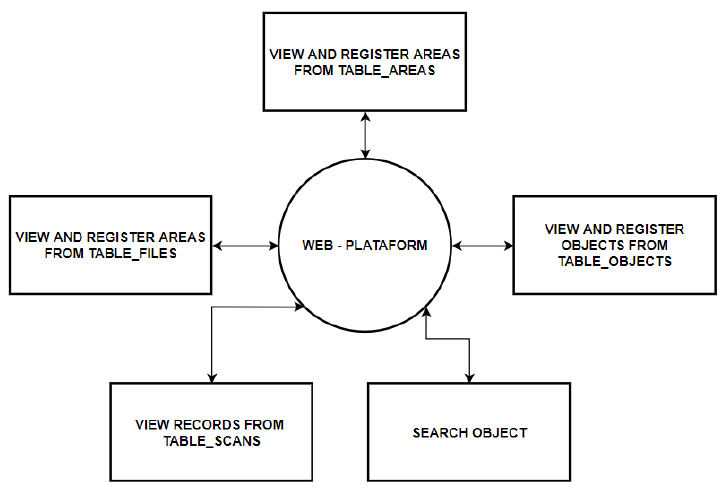
Figure 16. Structure of the developed Web-Platform.